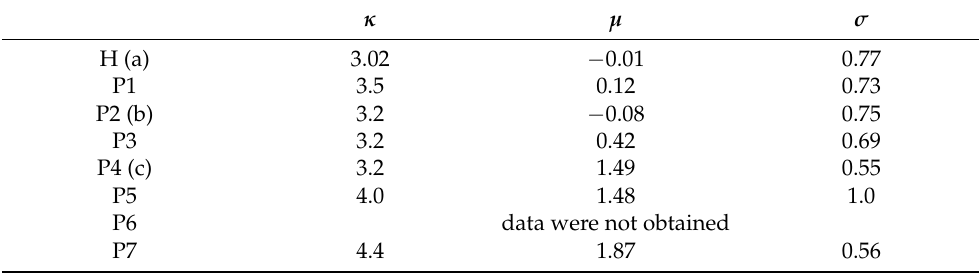
Table 4. Kurtosis ( κ ), mean ( µ ), and standard deviation ( σ ) for the distribution of ratio of muscle activities R W for a healthy participant (H) and stroke patients